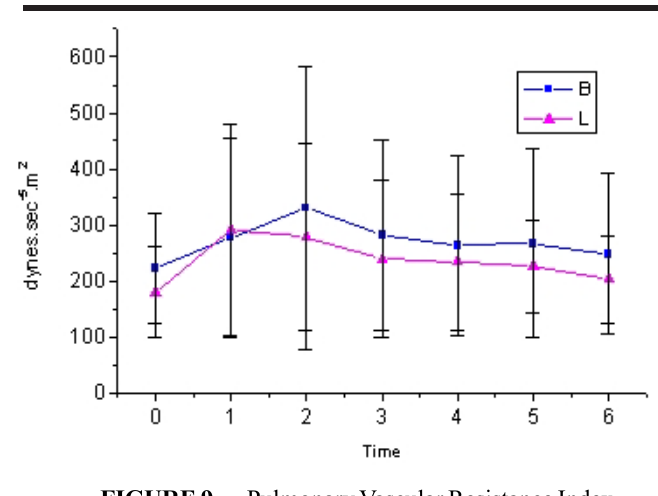
FIGURE 9 — Pulmonary Vascular Resistance Index